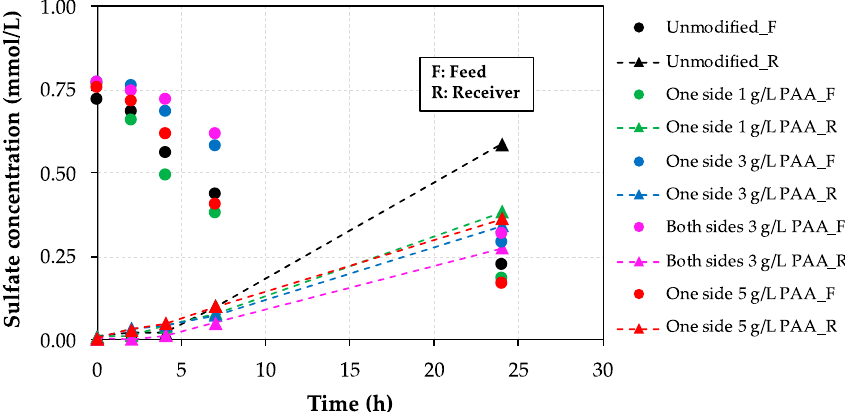
Figure 8. Sulfate evolution with time during mass transport experiments as a function of the AEM used in the absence of humic acid (HA) in the feed compartment.